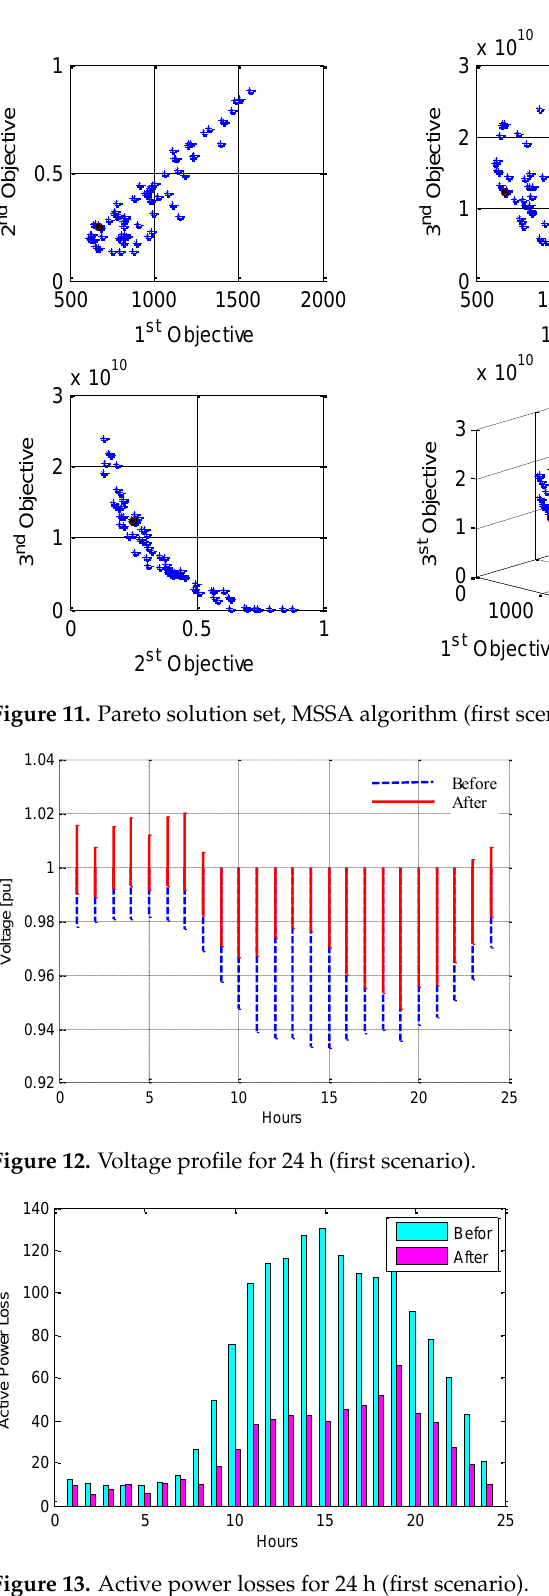
12 of 18 Table 6. Optimal results of the algorithms for the first scenario. Algorithms